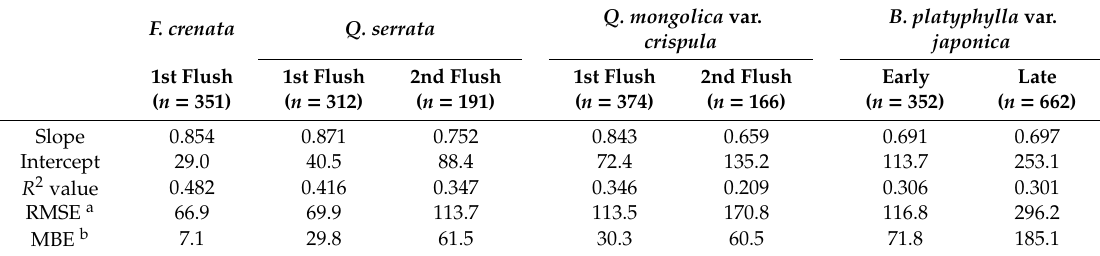
− 2 LA s − 1 ); b MBE: Mean bias 2 O m